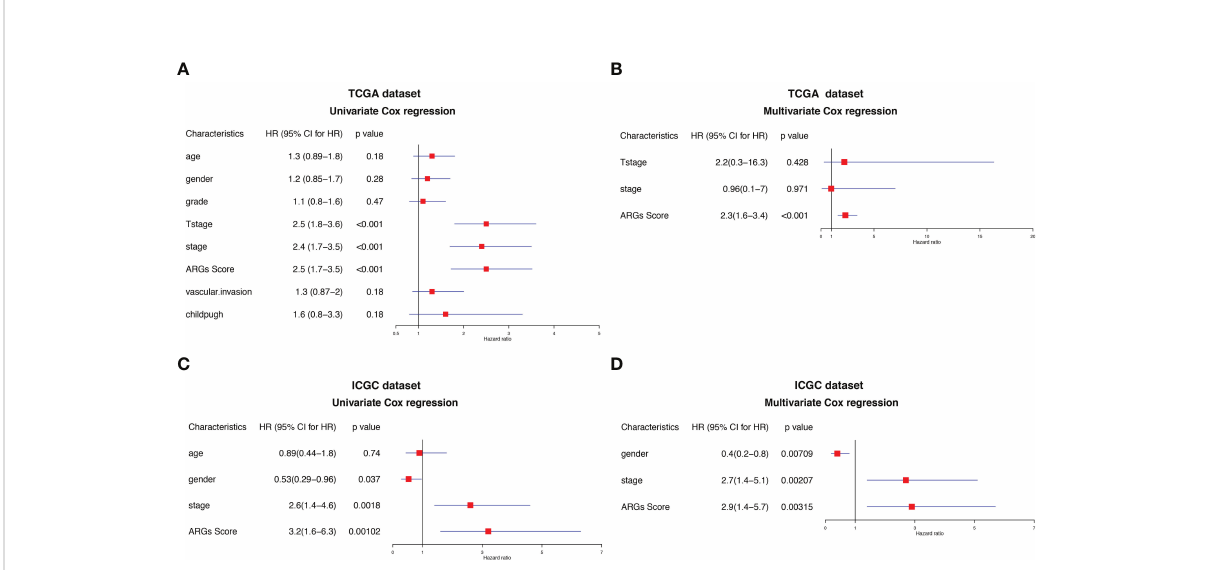
FIGURE 7 Univariate and multivariate Cox regression analysis of the ARGs Score. Univariate Cox regression analysis in the (A) TCGA and (C) ICGC cohorts. Multivariate Cox regression analysis in the (B) TCGA and (D) ICGC